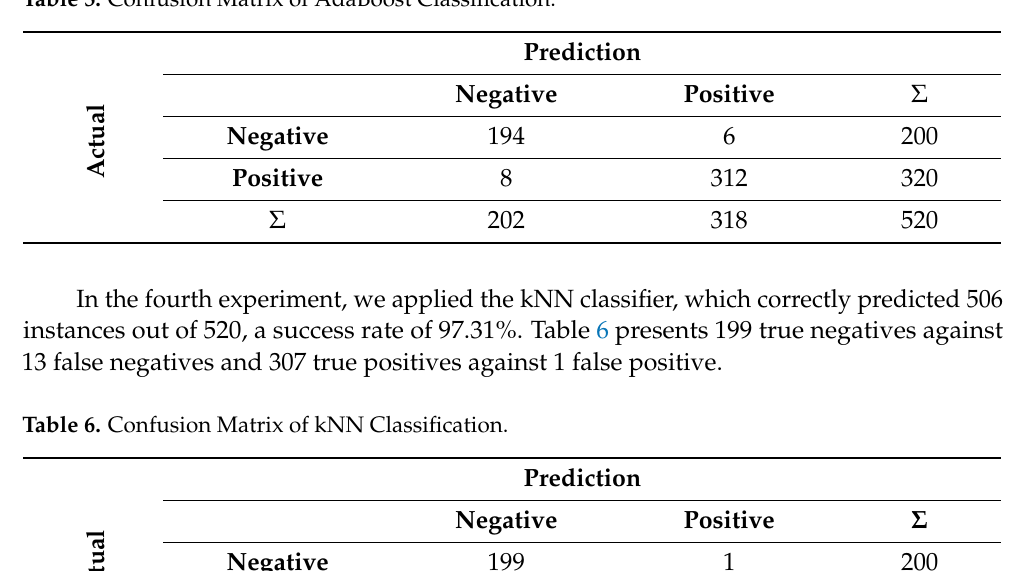
Table 5. Confusion Matrix of AdaBoost Classification.